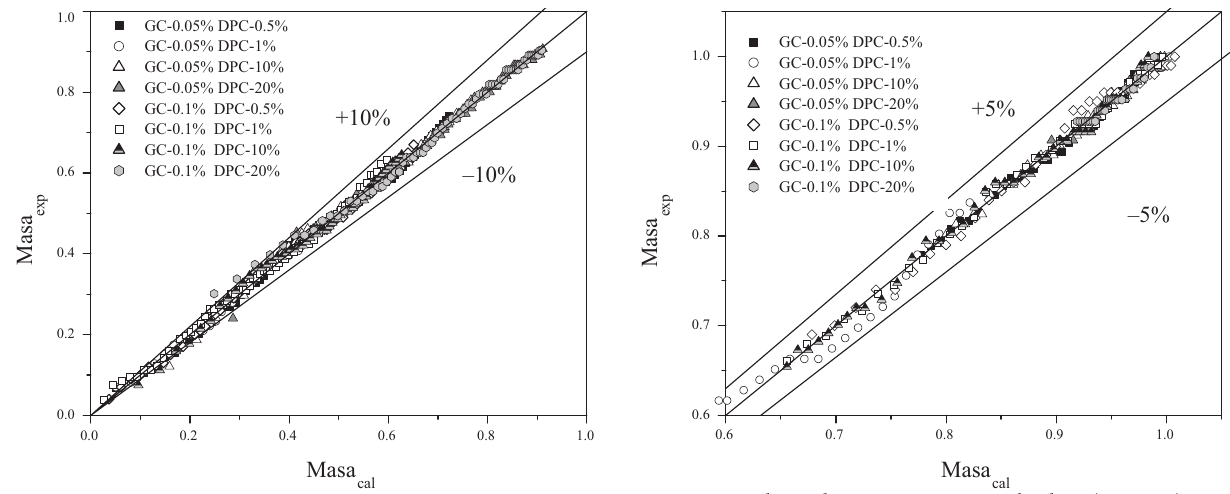
phase of the imbibition process